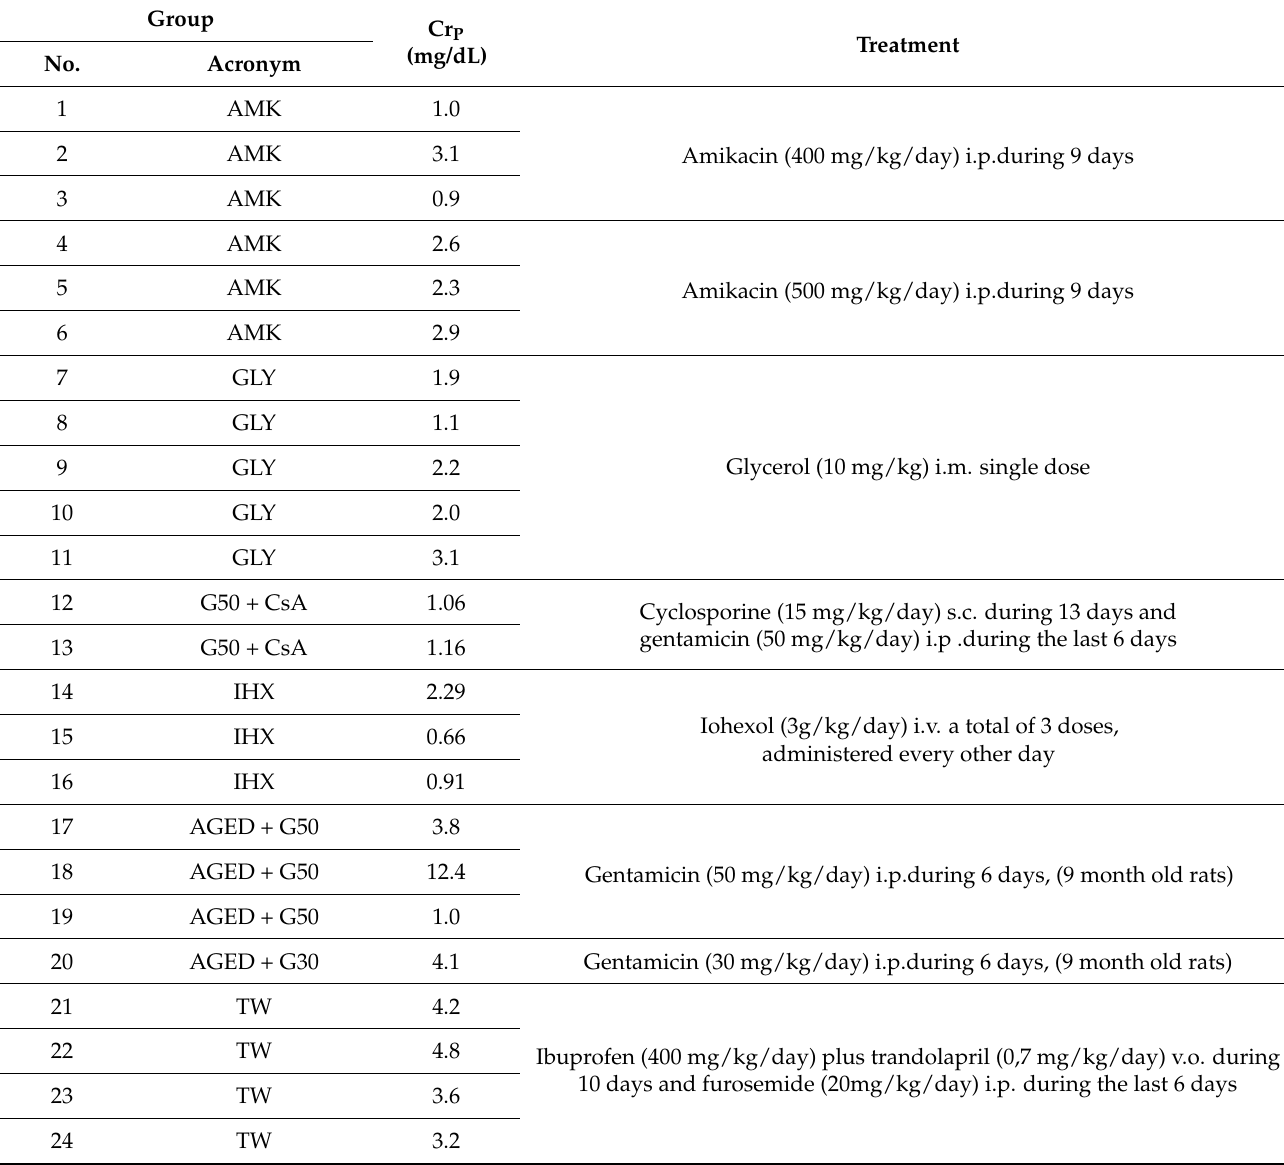
Table 2. Animal characteristics. Animal model (i.e., AKI model), drug dose, and plasma creatinine concentration (Cr p ) for each individual rat included in the study. Cr P (mg/dL)